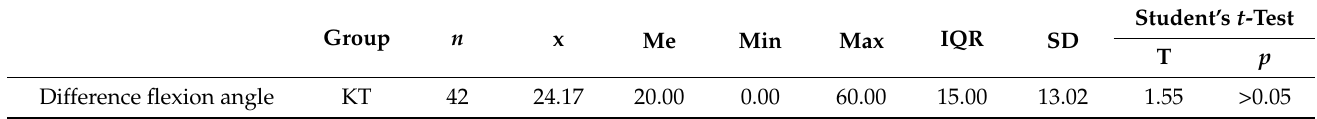
Table 6. Difference in knee flexion angle.